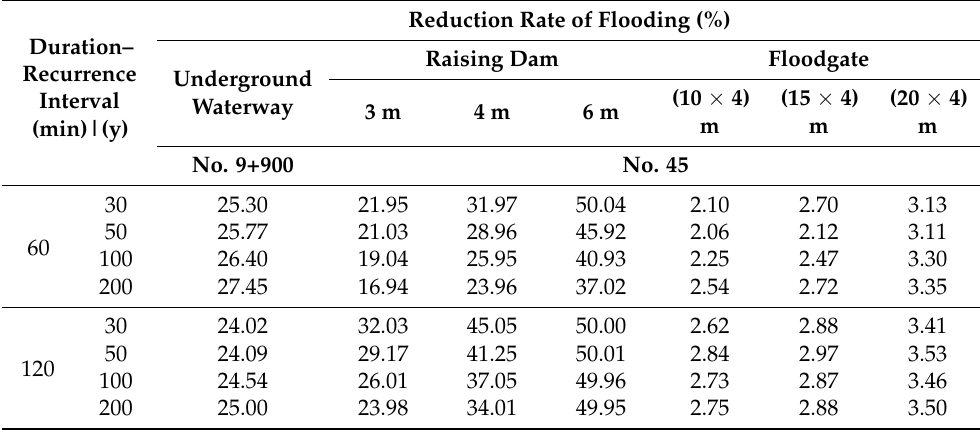
Table 1. Flood reduction rates in the Suyeong and Oncheon rivers (rainfall quantile).